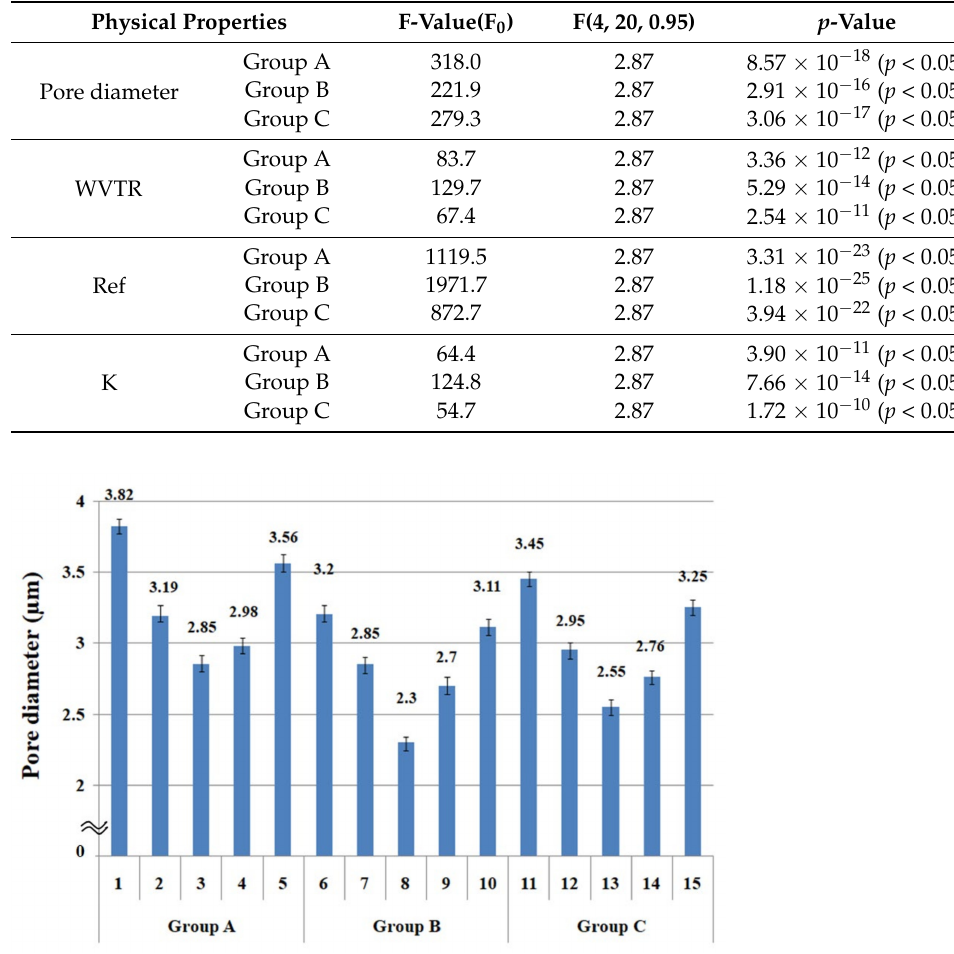
Table 5. ANOVA analysis of the fabric physical properties.